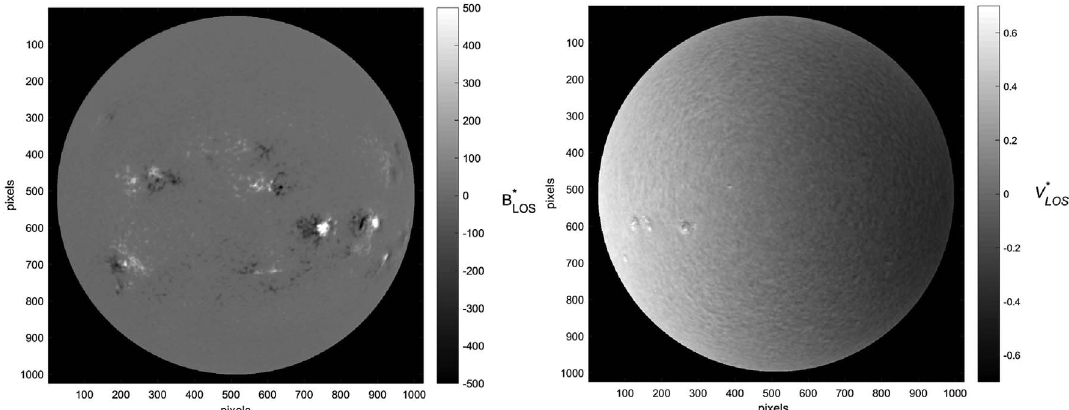
Fig. 10. Sample of a solar K B (cid:3) LOS magnetogram ( left panel ) and V (cid:3) LOS Dopplergram ( right panel ) synoptic maps acquired at 19:25 UT 2014 July 9th, expressed in arbitrary units. The spatial resolution of the images is 2 arc-second.